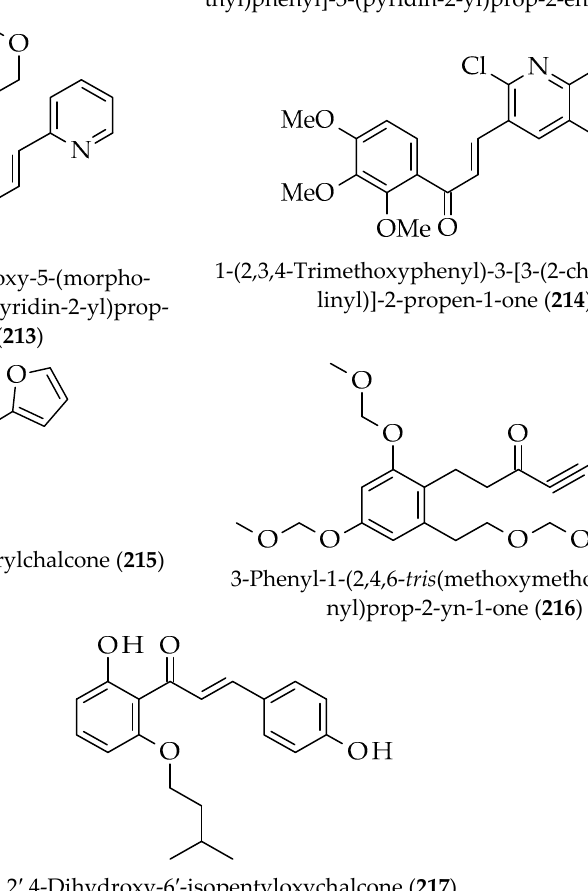
Figure 19. Structures of some synthetic immunomodulatory chalcones.